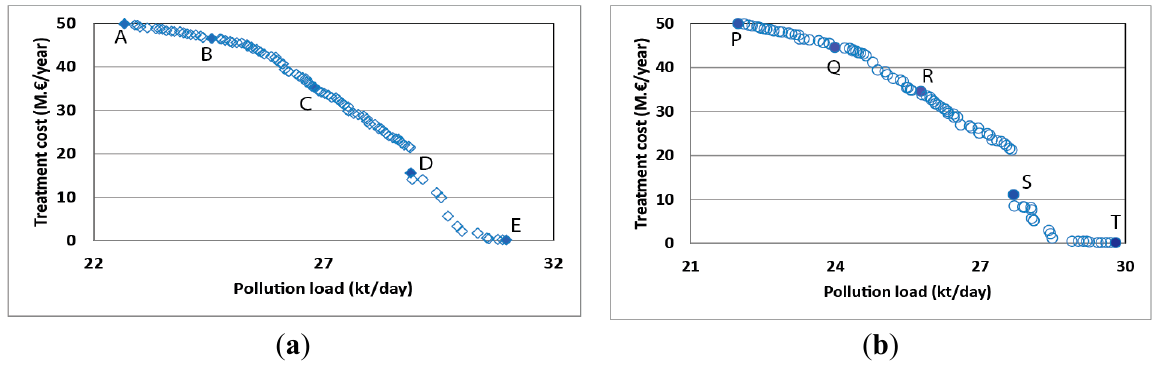
Figure 5. Pareto optimial fronts after 3 h runoff. ( a ) For migrating downstream; ( b ) For migrating